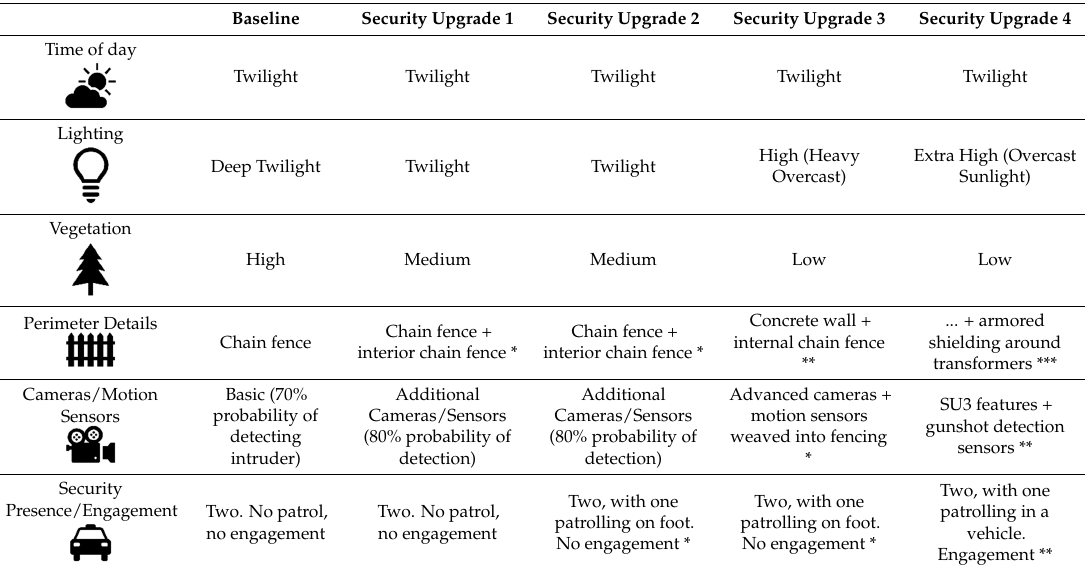
Table 6. This schematic indicates the effectiveness of security mitigation strategies, where *** indicates the most effective security upgrade measures, ** the second most, and * the third most.